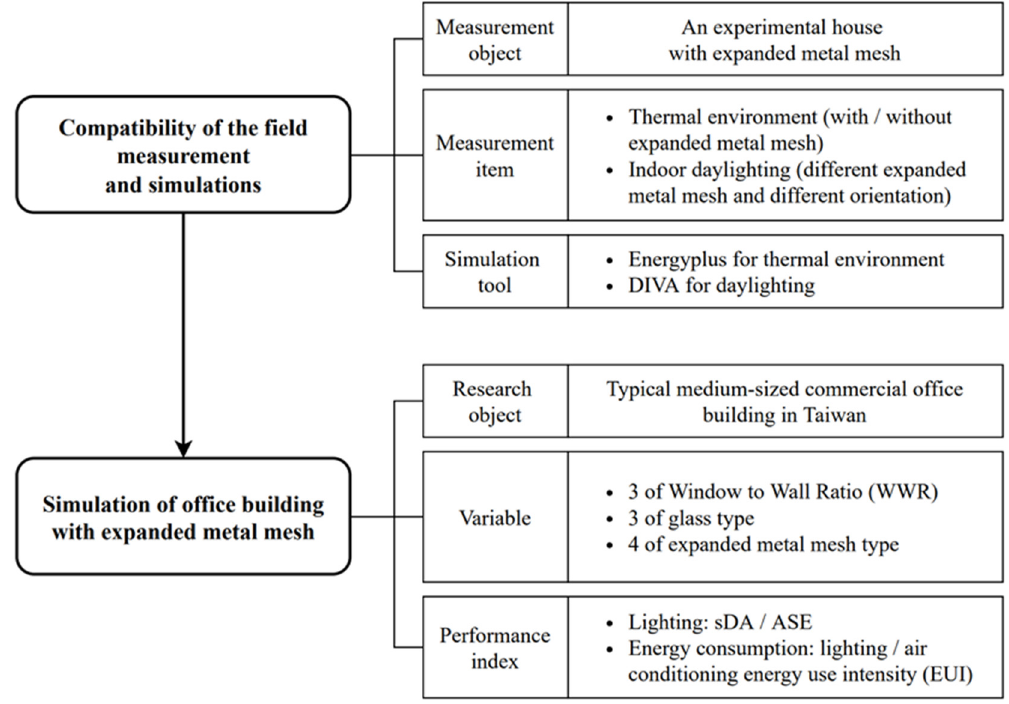
Figure 1. Workflow of this research.